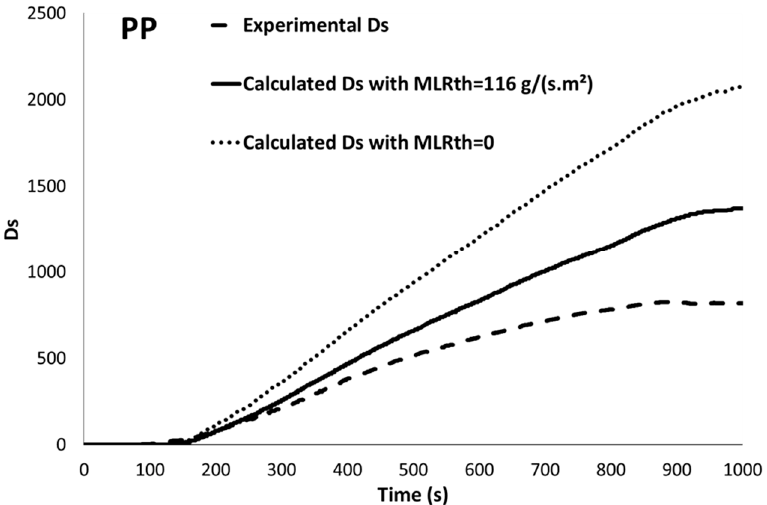
Figure A1. Experimental and calculated Ds versus time for PP–Ds was calculated considering two values of MLR th